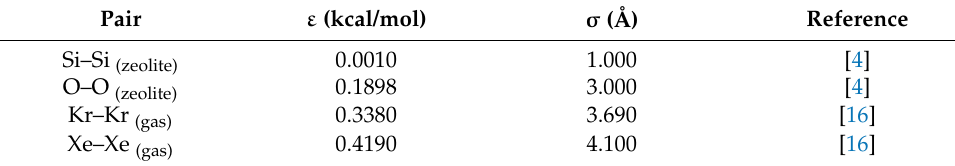
Table 1. 12-6 Lennard-Jones potential parameters.